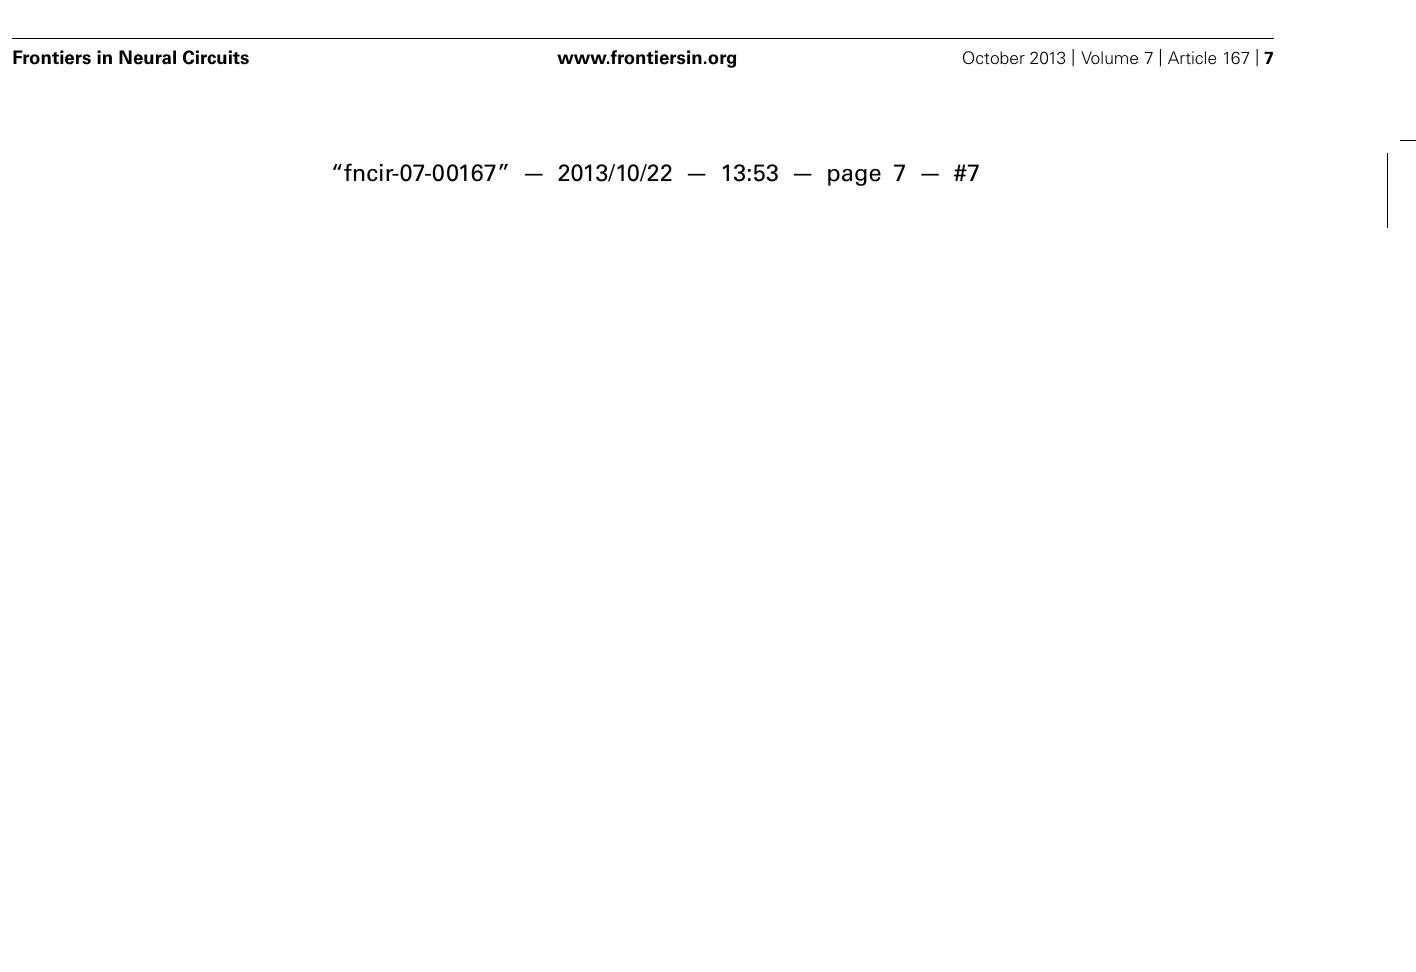
Figure 5B ; p > 0.05 in both cases, Wilcoxon rank sum